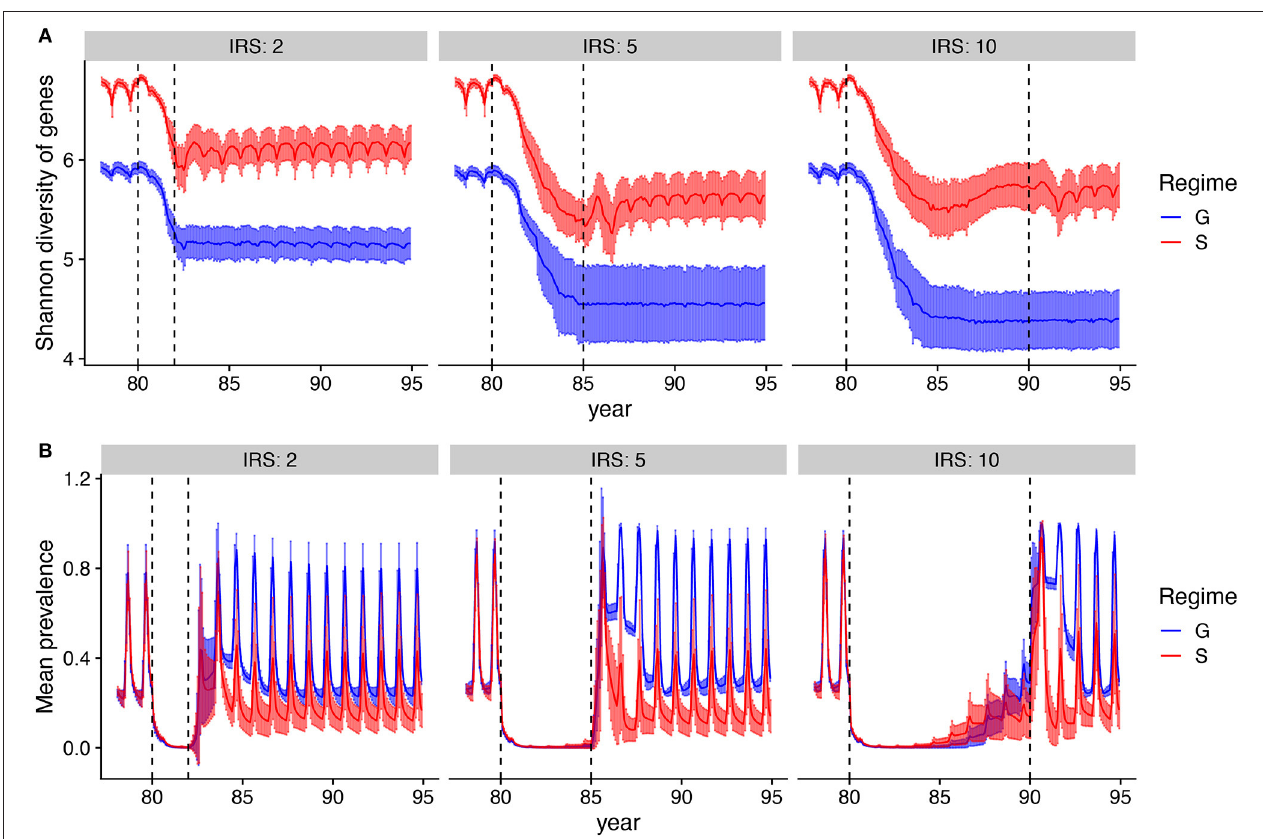
FIGURE 5 | Dynamics of genetic diversity and prevalence during and after IRS. (A) Mean Shannon diversity (solid line) and standard deviation (error bars) of var gene types are tracked over time. Shaded areas show the extent of the variation across runs. (B) Mean changes in prevalence (solid line) and its variation (error bars) over time. After IRS, prevalence returns back to pre-IRS stage under generalized immunity (G), whereas it gravitates to a lower level under specific immunity (S). Parameters: gene pool size equals 9,600 and transmission rate is high. Only runs that persisted after IRS are